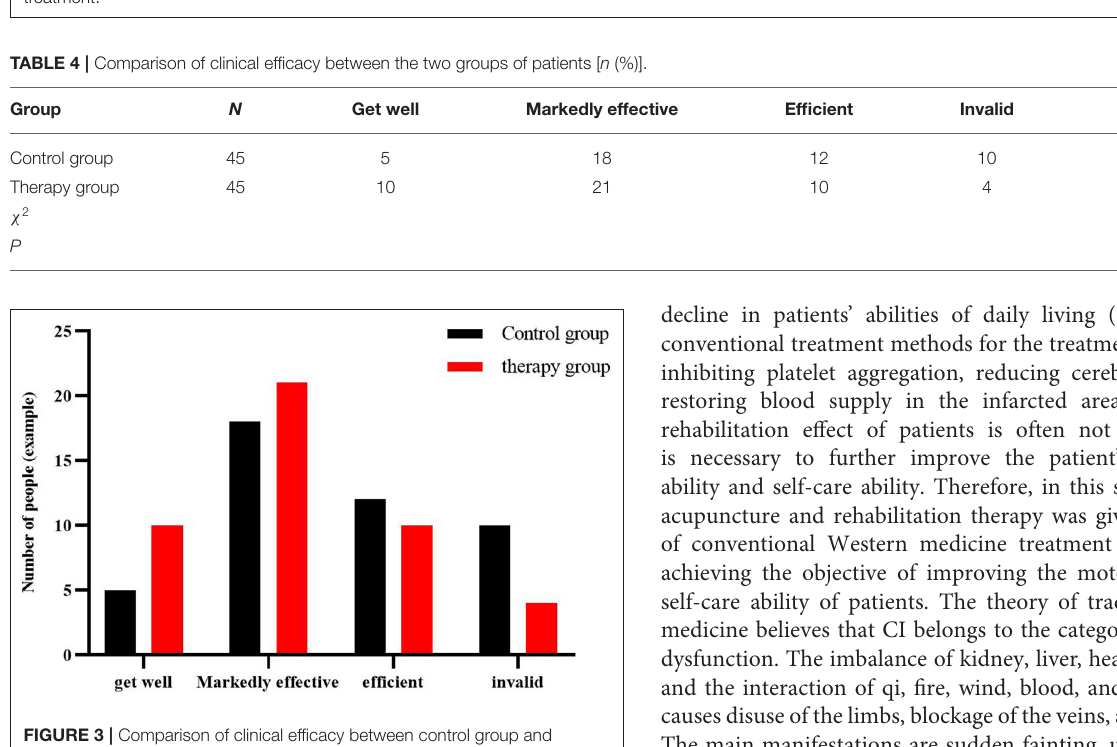
FIGURE 2 | Comparison of FMA scores before and after treatment between the two groups (M ± S D, scores). (A) Comparison of FMA scores of the control group before and after treatment; (B) Comparison of FMA scores of the therapy group before and after treatment; (C) Comparison of FMA scores of the two groups after treatment.